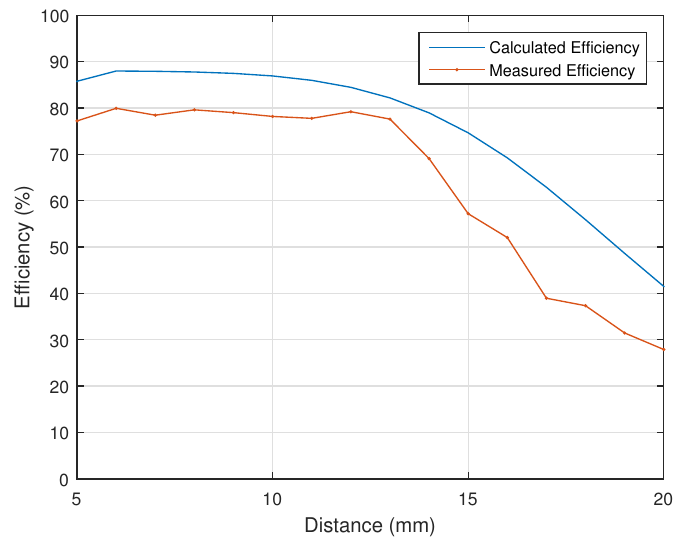
Figure 12. Comparison between the calculated and measured efficiencies of the system.